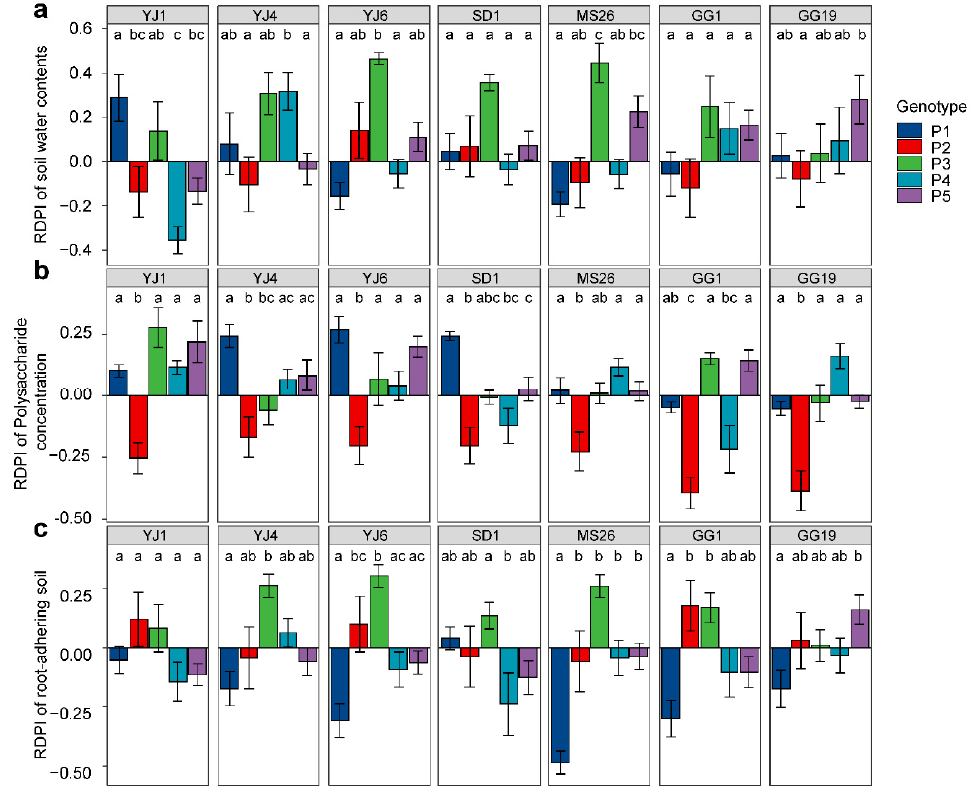
Figure 5. Plastic responses of different Lactuca serriola genotypes to bacterial treatments. Average relative distance plasticity indexes (RDPIs) and standard errors of ( a ) soil water contents, ( b ) soil polysaccharide concentration, and ( c ) root-adhering soil are presented. Letters indicate statistically significant ( p < 0.05) differences among genotypes based on Tukey’s multiple comparison tests. The names of bacterial strains are given in Figure 1.